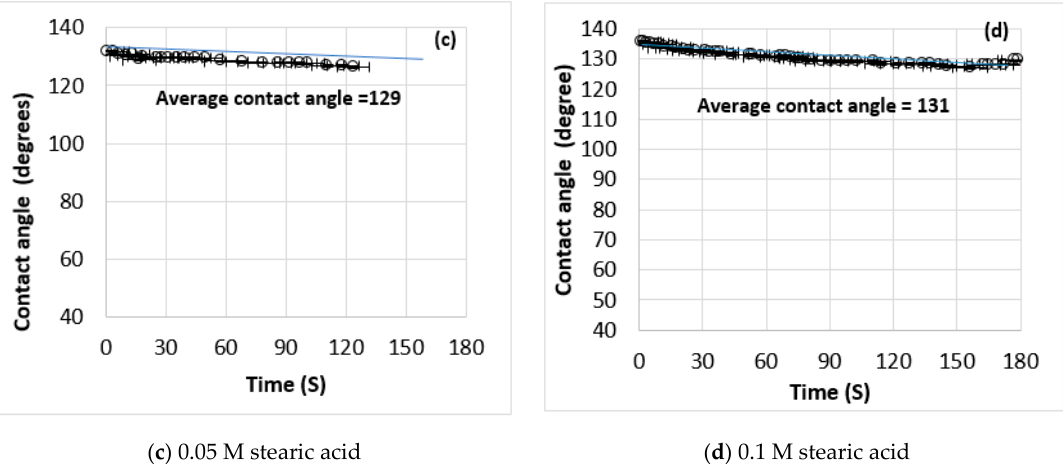
Figure 7. Measured contact angle versus time on modified calcium carbonate equilibrated by solutions of stearic acid in n -decane in the presence of water at concentrations of: ( a ) 0.015 M, ( b ) 0.020 M, ( c ) 0.050 M, and ( d ) 0.100 M.